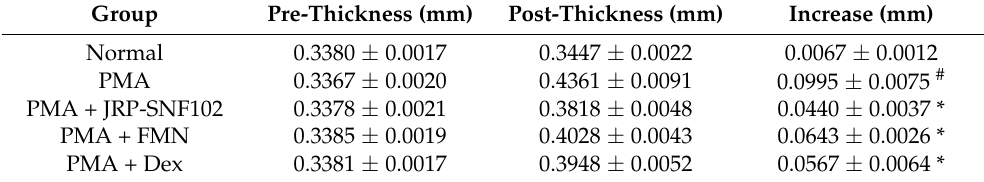
Table 2. The increase of ear thickness.